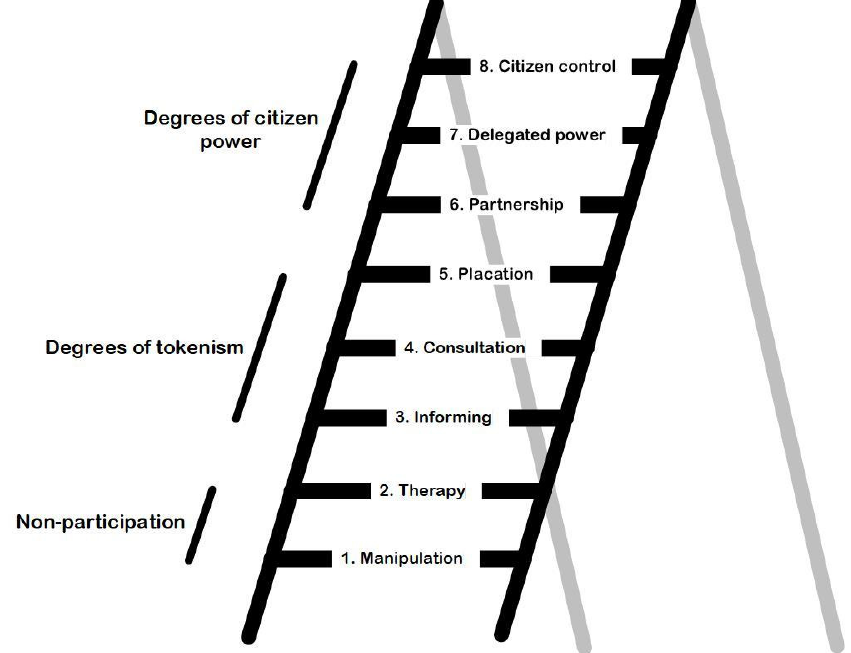
Figure 1. The eight rungs of the ladder of citizen participation [21], adapted from Arnstein [42] (p. 217) and taken from van Hoof et al. [21].